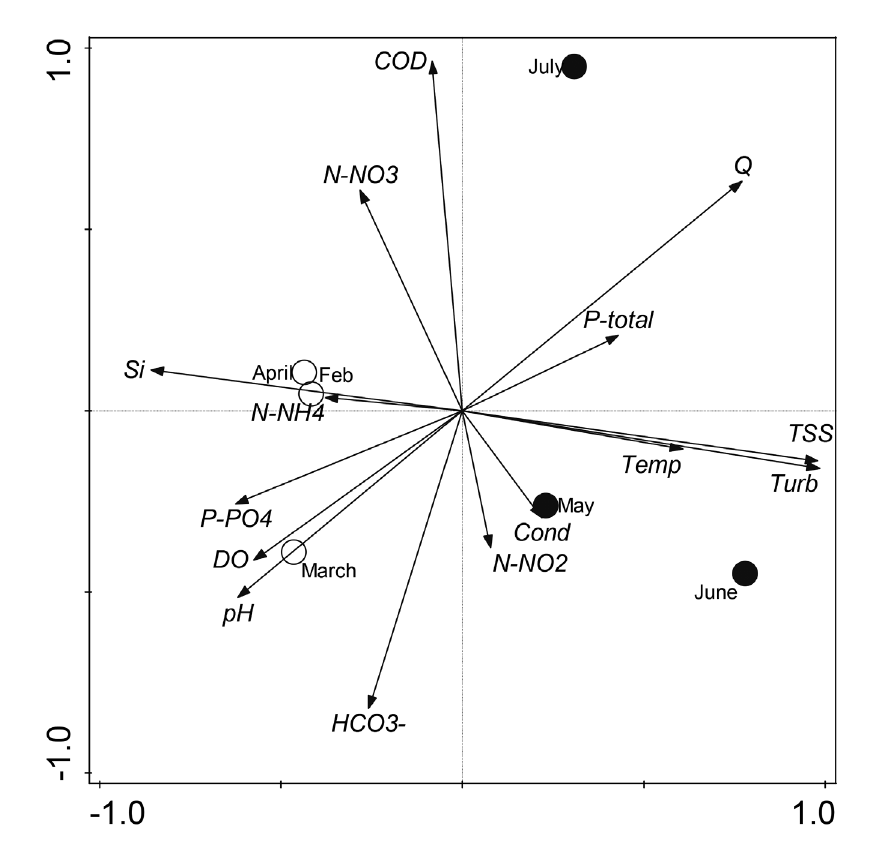
Figure 3 – PCA of water chemistry and physicochemical variables with samples from dry season (February–April; open circles) and wet season (May–July; closed circles). Eigenvalues are λ